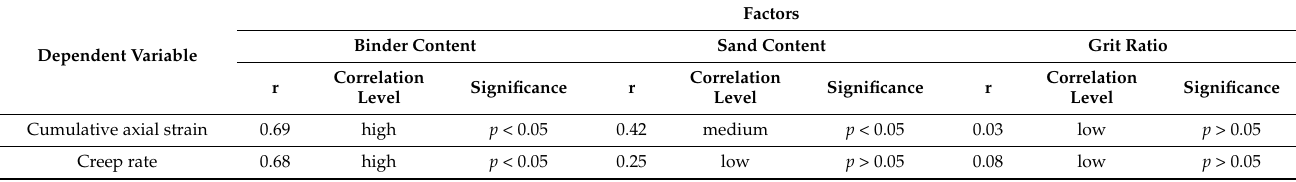
Table 2. Correlation analysis